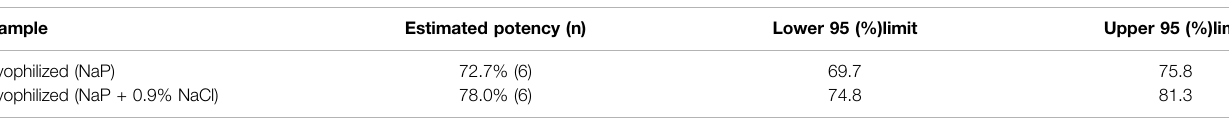
TABLE 3 | Potency estimates for IL-6 SS-889 trial run relative to unformulated bulk IL-6.